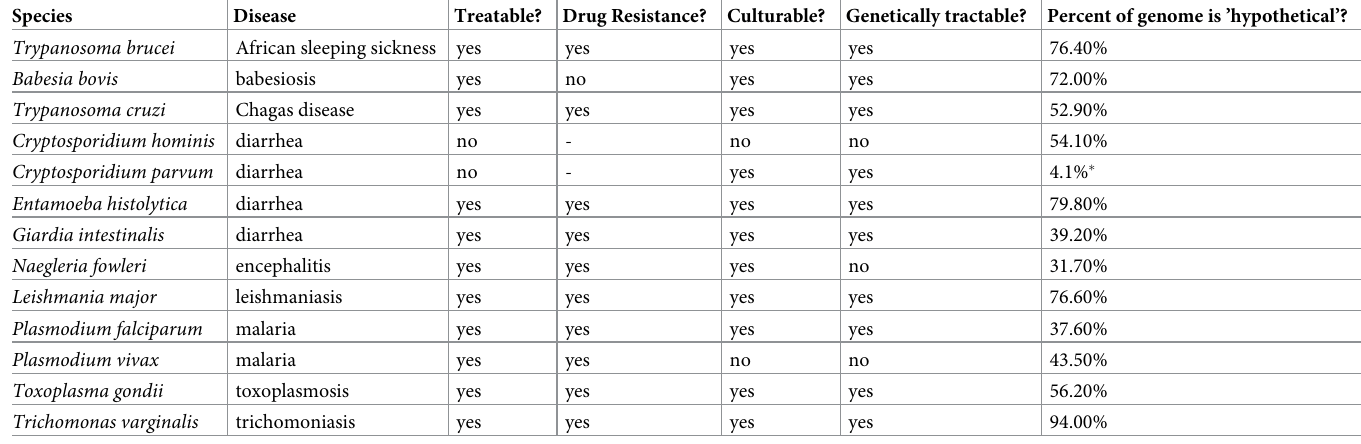
Table 1. Summary of select parasitic diseases and their causal organism. Parasites cause important human and animal diseases and have unique biological and experi- mental challenges that have made interpretation of in vivo and in vitro data challenging. Several examples are shown. Current treatments and associated observed drug resistance are noted. Many well-studied parasites remain refractory to genetic modification and/or still have poor genome annotation. ‘Uncharacterized’ genes were identi- fied via EuPathDB searches for terms such as ‘uncharacterized’, ‘putative’, ‘hypothetical’, etc., for a representative strain. Because each database is heavily influenced by the respective scientific community, some databases such as CryptoDB do not use these terms because the function of so few genes have been validated in the Cryptosporidium parasites. Thus, the genomes of the Cryptosporidium parasites are mostly hypothetical and proposed functions are only putative; the reported percent of genome that is hypothetical is low for this reason (highlighted by an